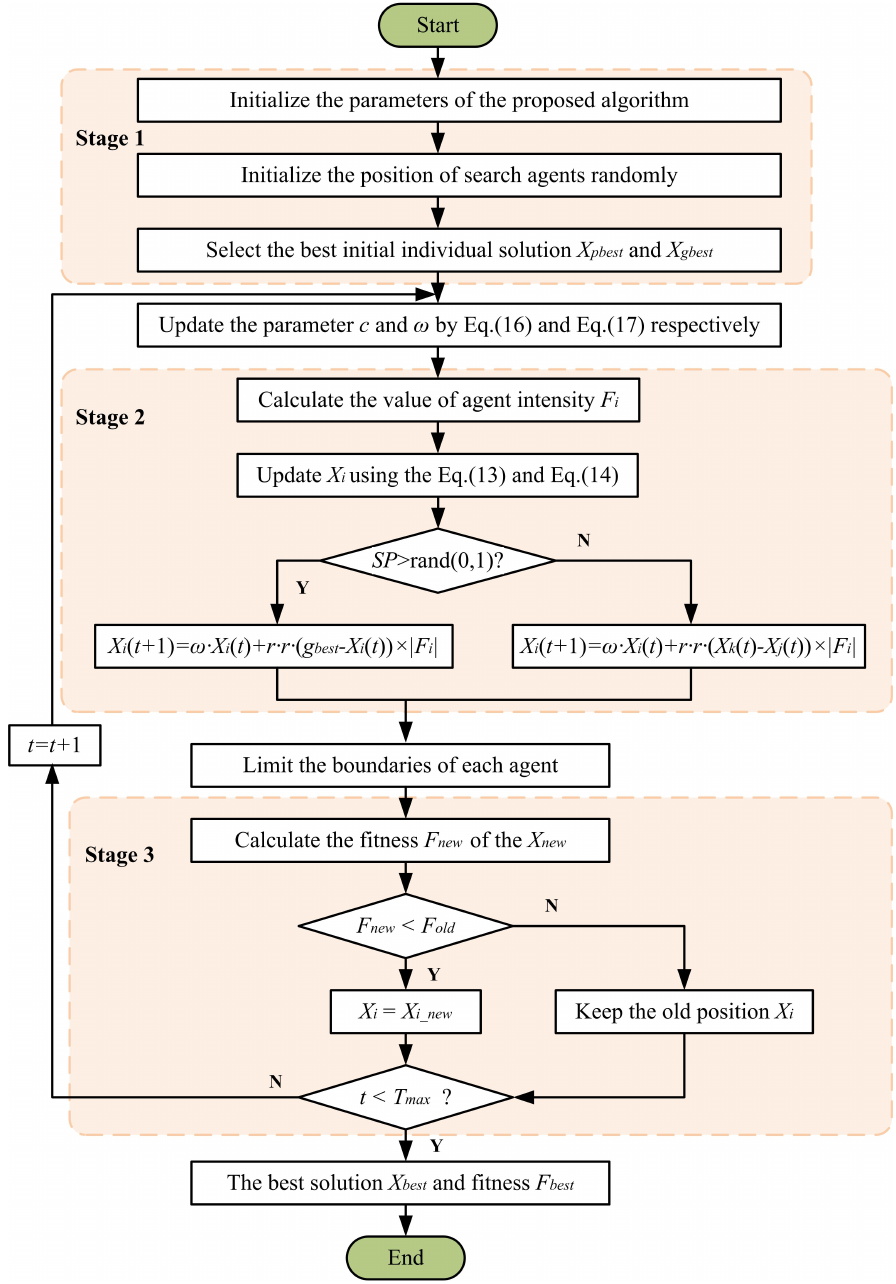
Figure 6. The flowchart of the proposed